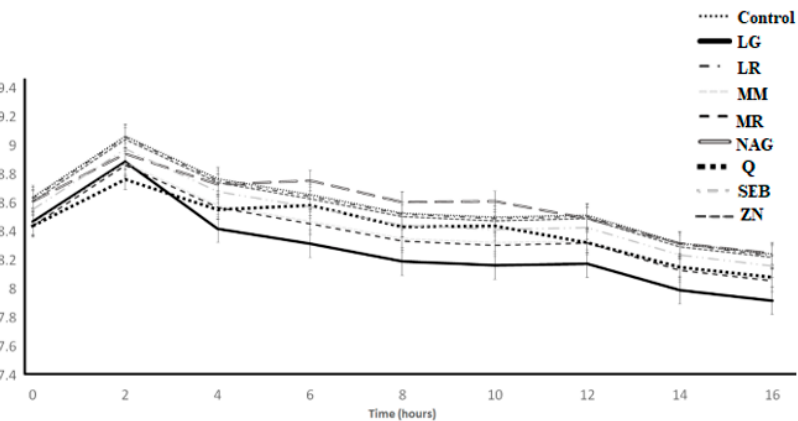
Figure 5. Log counts of Streptococcus thermophilus showing its growth as influenced by ingredients over the incubation period of 16 h. C = control, LG = L-glutamine (7 g/L), Q = quercetin (700 mg/L), SEB = slippery elm bark (210 mg/L), MR = marshmallow root (1340 mg/L), NAG = N-acetyl-D- glucosamine (210 mg/L), LR = licorice root (210 mg/L), MM = maitake mushrooms (42 mg/L), and ZN = zinc orotate (70 mg/L). Error bars represent SE.